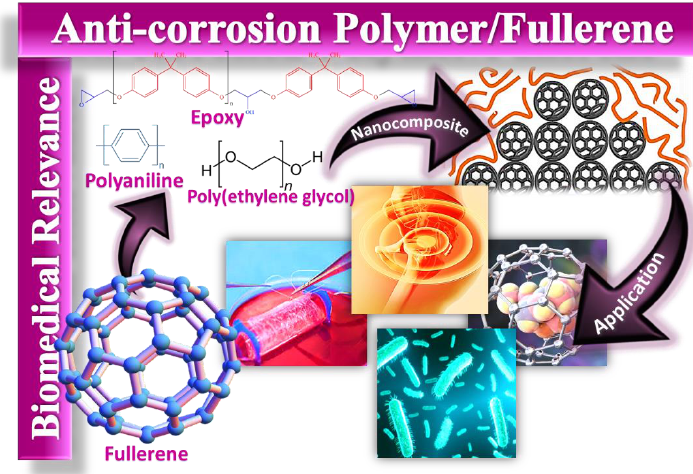
Figure 7. Significance of corrosion-resistant polymers/fullerenes.